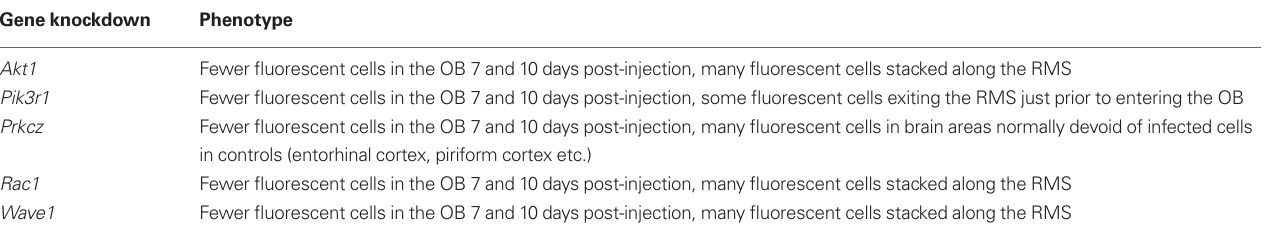
Table 3 | Phenotypes of animals infected into aSVZ/pRMS by AAV viruses expressing gene-specifi c shRNA and red fl uorescent protein. Gene knockdown